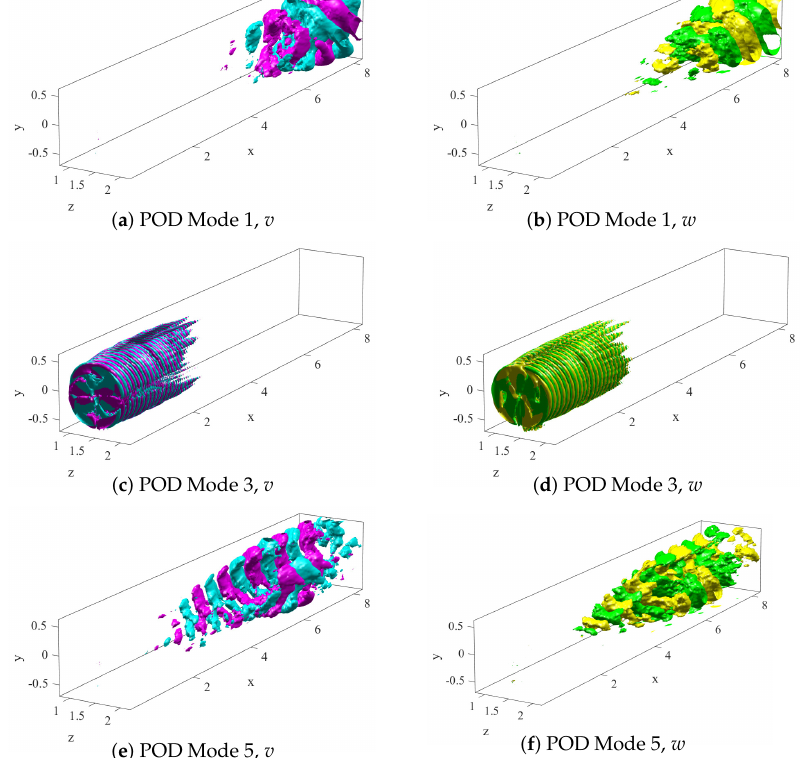
Figure 5. Vertical ( left ) and transverse ( right ) velocity iso-surfaces of the most energetic POD modes (magenta/green for v , w = 0.0008, cyan/yellow for v , w = −